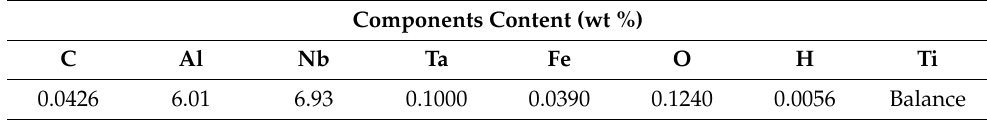
Table 1. Chemical composition of the Ti-6Al-7Nb